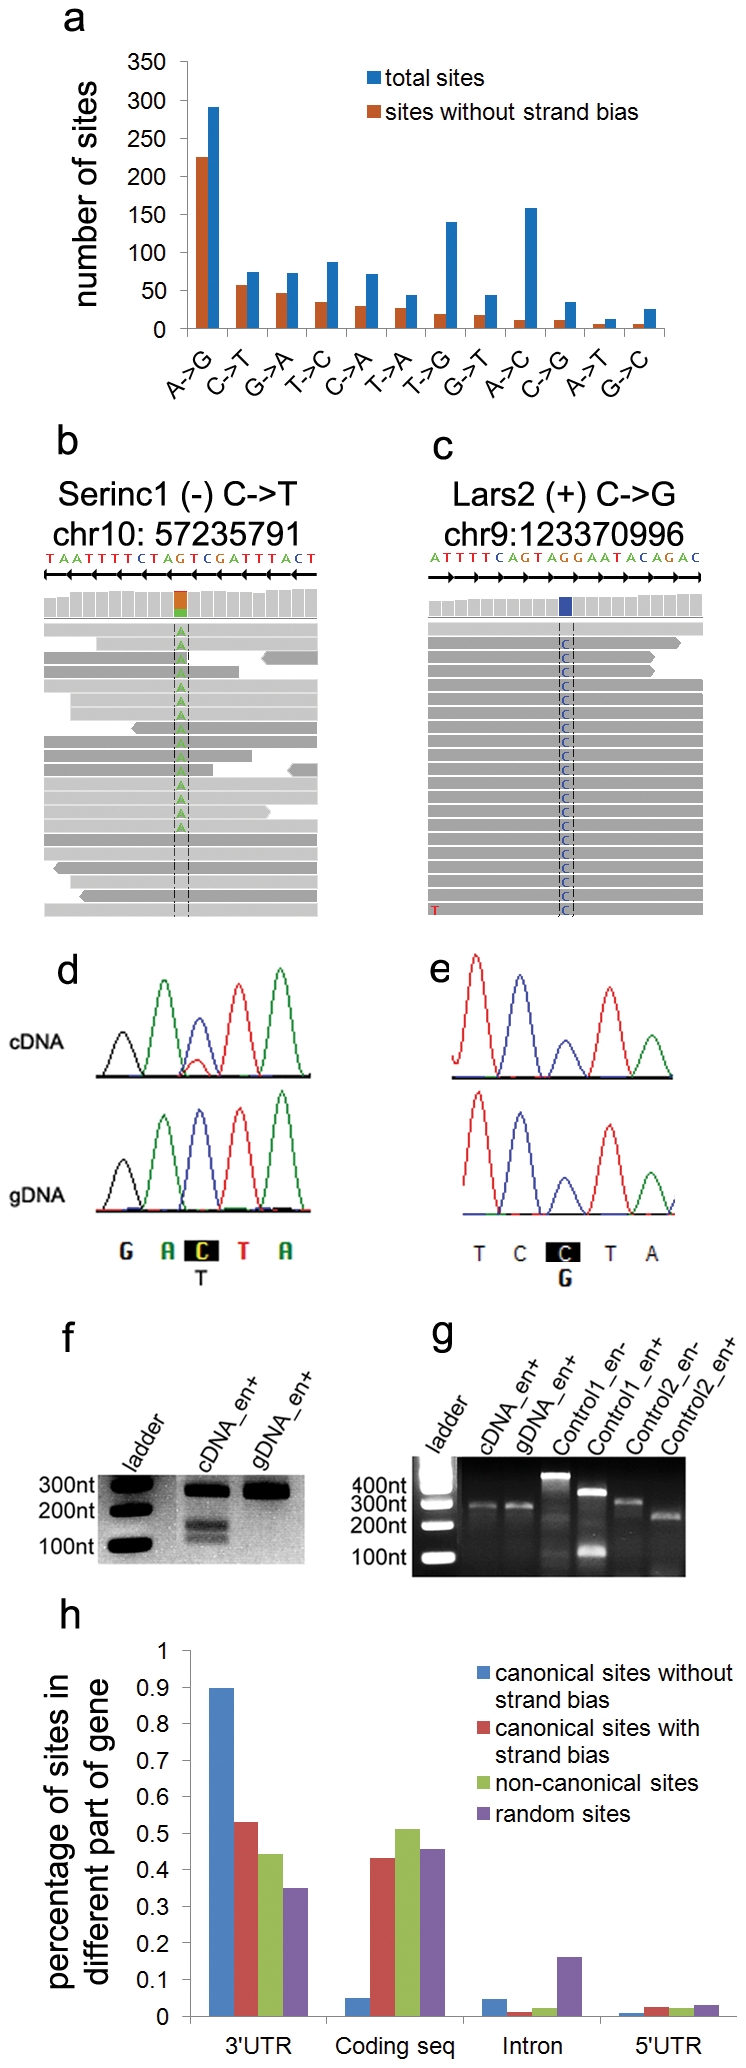
Distribution and validation of editing sites observed in RNA-seq data.A) Distribution of RNA editing types with and without a filter for significant strand bias from RNA-seq data. B,C) RNA-seq traces are shown for one canonical RNA editing site (C-to-U in Serinc1) and for one non-canonical editing site (G-to-C in Lars2). Reads sequenced in the sense direction are shown in dark grey, while reads sequenced in the reverse direction are shown in light grey. D,E) Sanger sequencing validation results for sites in Serinc1 and Lars2. F,G) RFLP validation of sites in Serinc1 and Lars2. Samples exposed to enzyme are labeled “en+” and control samples are labeled “en-.” H) Genomic distribution of editing sites and random background.